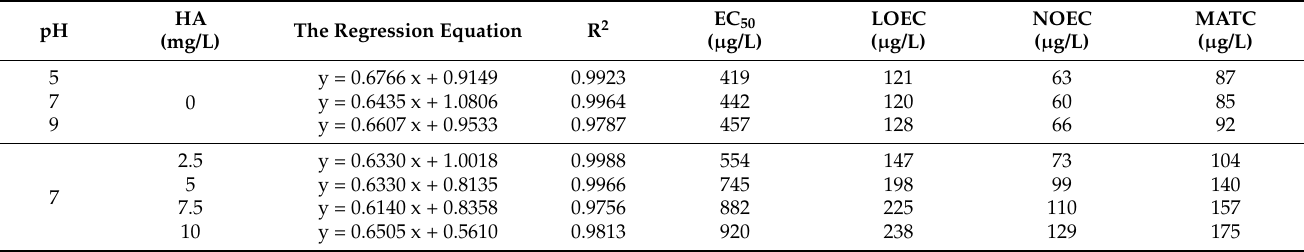
Table 1. The influence of pH and DOM on the toxic effects of Lindane on M. aeruginosa (96